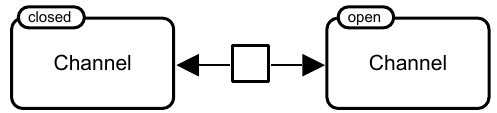
Figure 2.26: Reversible opening and closing of an ionic